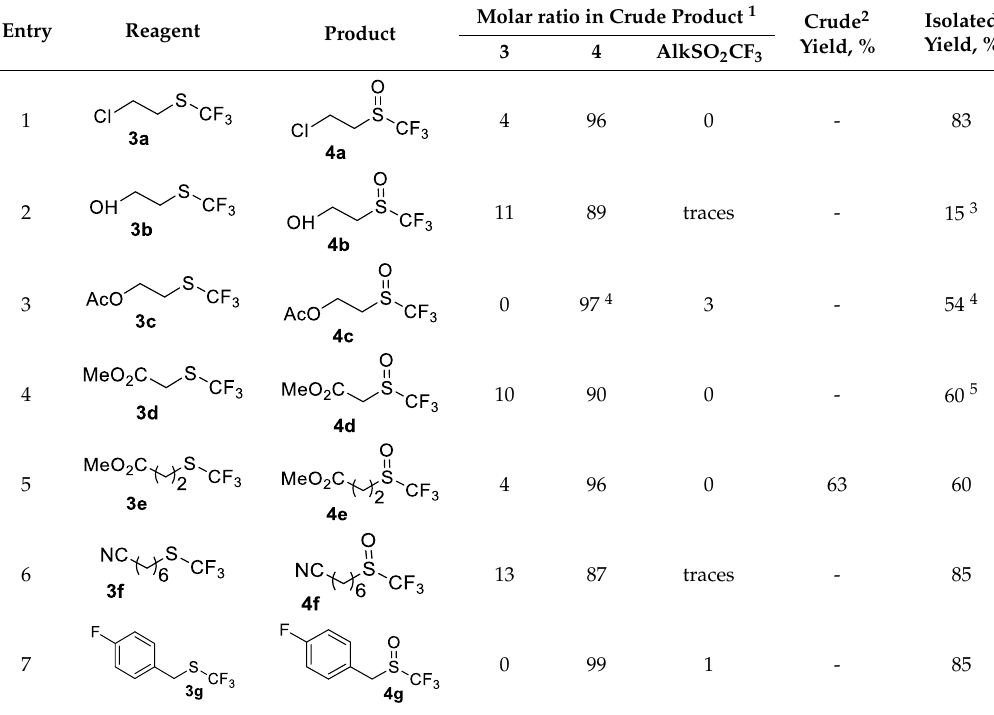
Table 2. Oxidation of alkyl trifluoromethyl sulfides 3 .